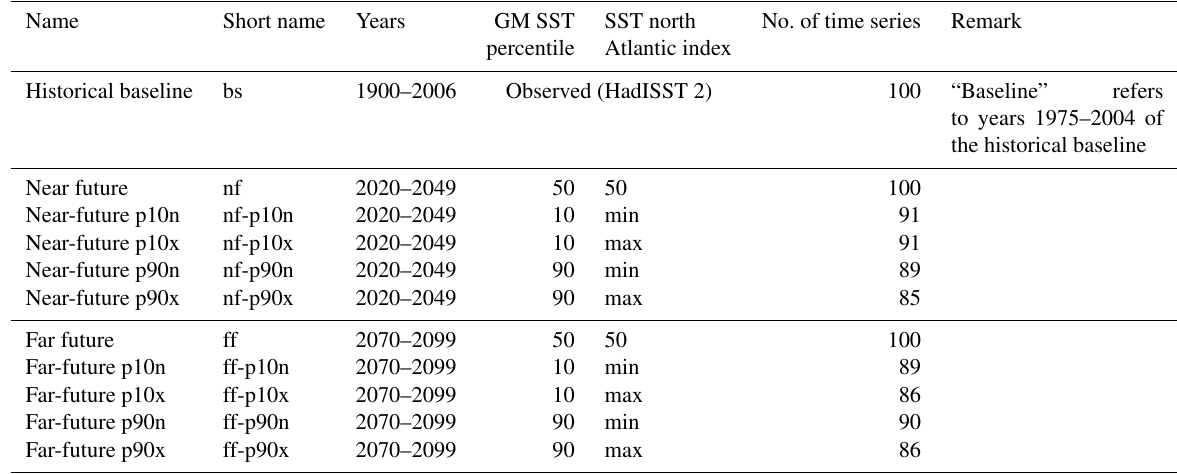
Table 2. List of the climate time series for various scenarios. GM SST stands for global mean